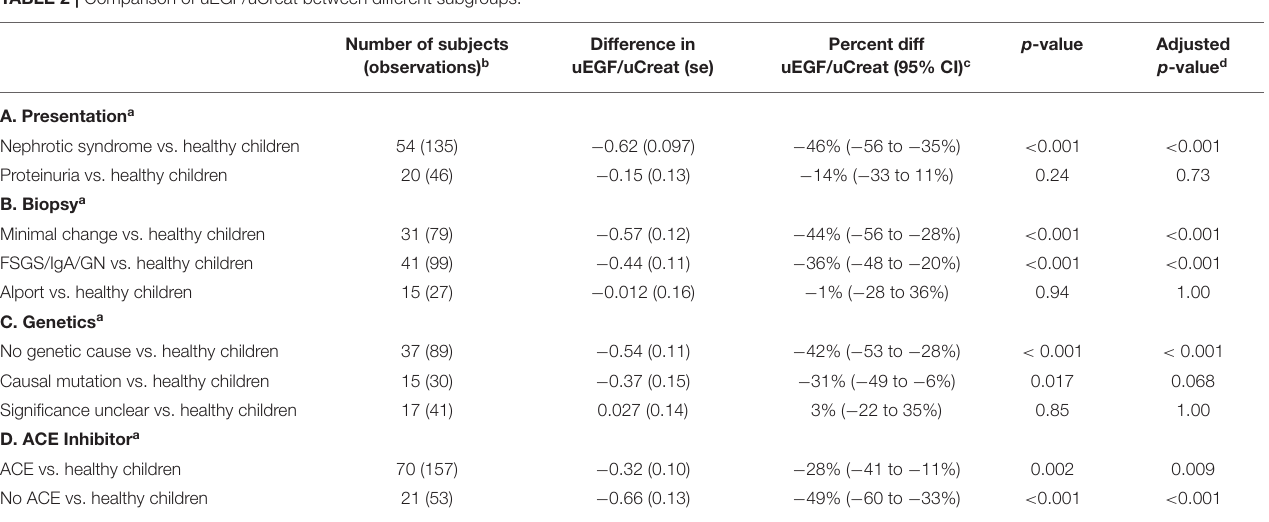
p -value Adjusted p -value